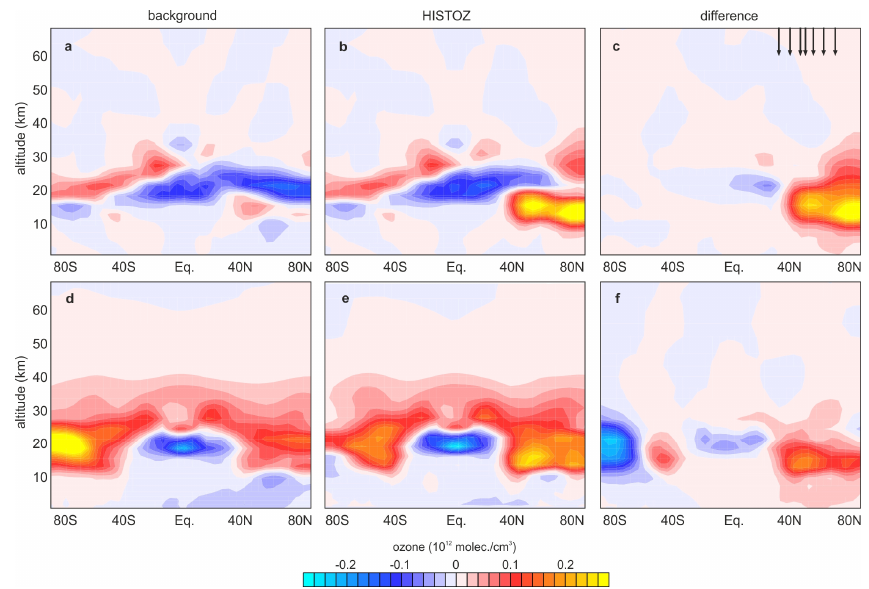
Fig. 10. Annual mean zonal-mean ozone differences for El Niño and La Niña for (a, d) the background, (b, e) HISTOZ.1.0, and (c, f) the difference HISTOZ.1.0 minus background. Arrows in (c) indicate locations where observations were assimilated. The upper row shows the differences between 1940–1942 and the years 1939, 1943, and 1944, the lower row shows the difference between the years 1969–1970 and 1975–1976.